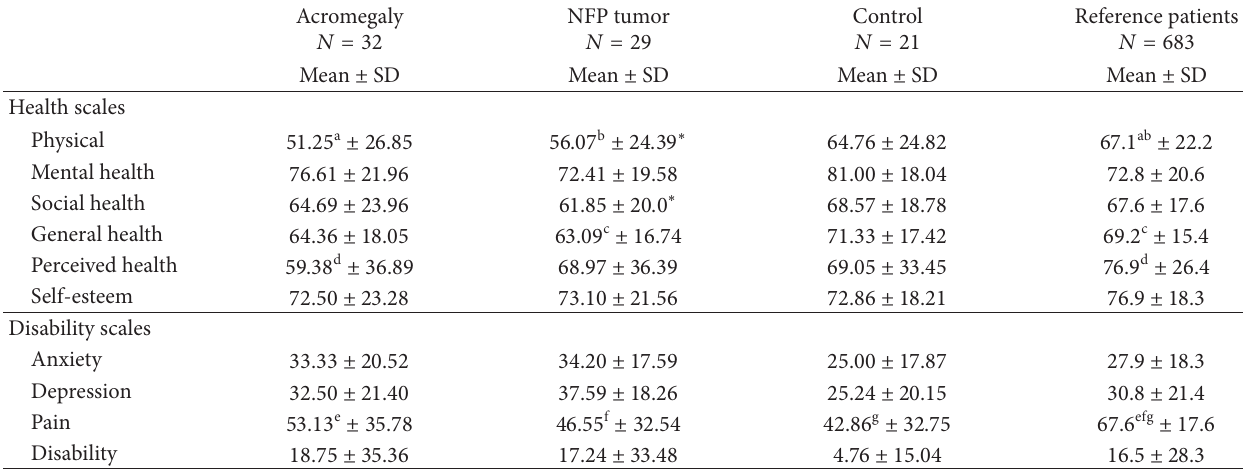
Table 5: Health and Disability Scales of the Duke Health Profile by participant